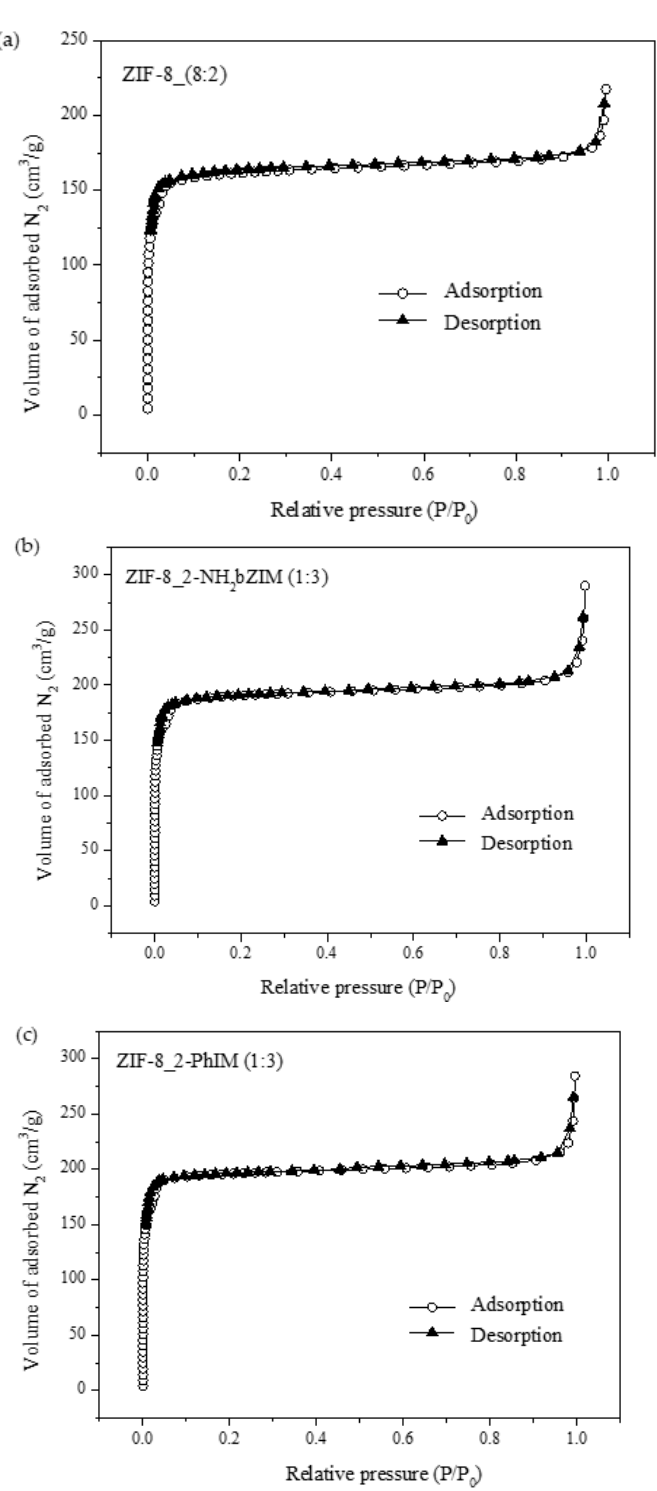
Figure 16. Comparison of CO 2 uptake of synthesized ZIF-8 by water based synthesis with hydrogen bond acceptor assisted and exchanged ZIF-8 at 313 K.